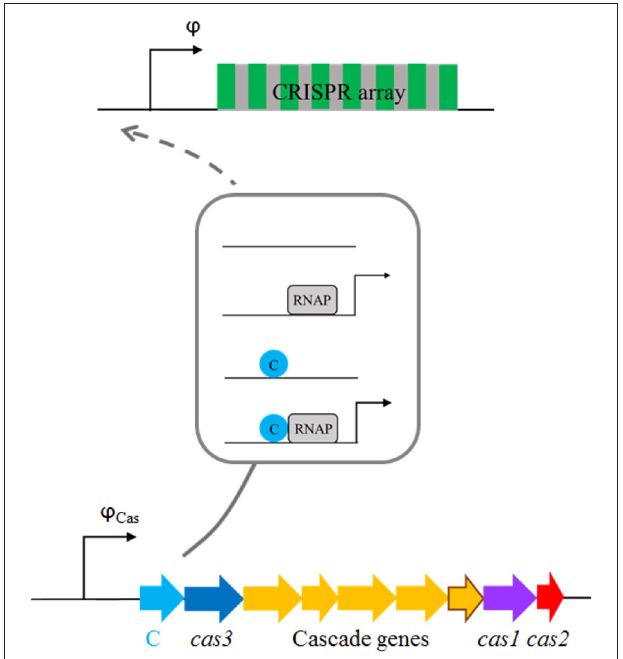
FIGURE 5 | Transcription regulation of cas and CRISPR array promoters in the cooperative model . The framed scheme shows promoter configurations, where transcription regulation is exhibited in the same manner as for Ahd I system, through cooperative interactions. Arrows in the scheme denote transcriptionally active configurations, with thicker arrow indicating larger promoter transcription activity. The full gray arrow indicates that cas promoter is regulated as described by the scheme, with the same parameters as in Ahd I R-M system ( Pougach et al., 2010). The dashed arrow indicates that the same transcription regulation is also exhibited for CRISPR array promoter, in the case when its transcription activity ϕ is not assumed